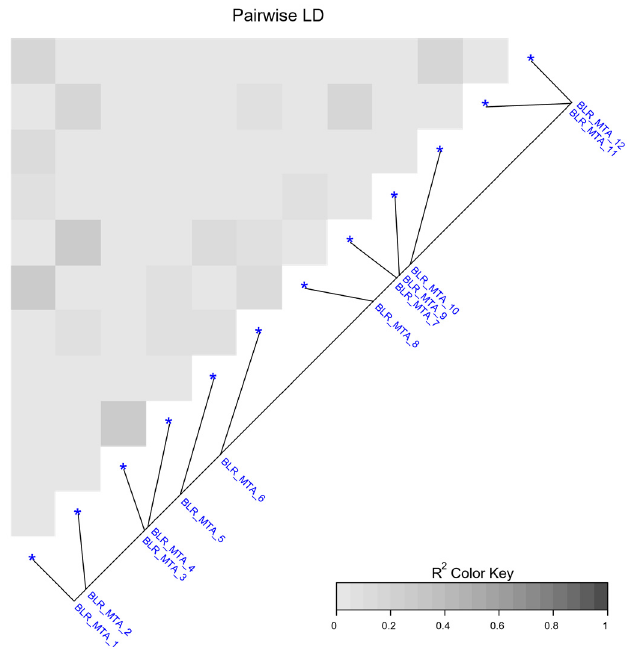
Figure 3. Linkage disequilibrium (LD) analysis of the 12 QTLs detected via GWAS performed on CAIGE lines. Heat maps represent pairwise LD as R 2 between pairs of markers.